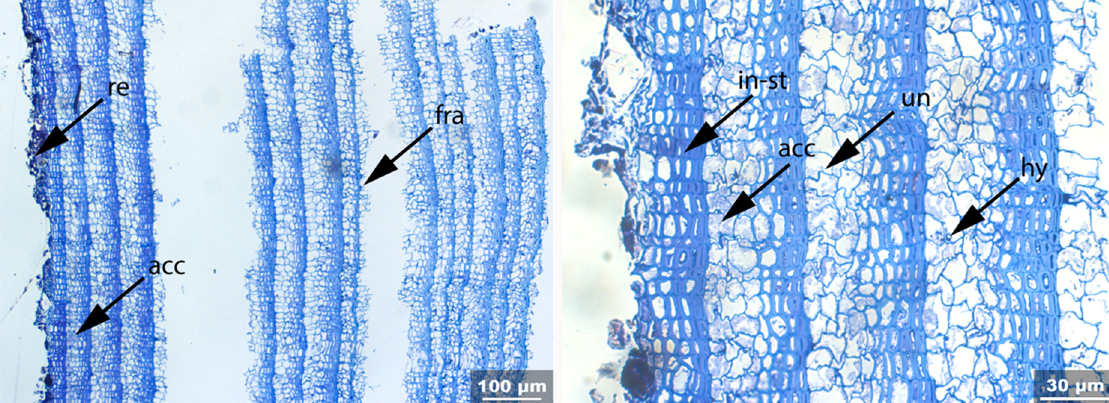
Figure 27. Sample 13. LM shows many fractures of radial thin-walled cells (fra) leading to delamination. Thin-walled cells are unfolded (un); thick-walled secondary cell walls reveal increased staining, especially close to the surface. Thick dark-coloured residue (re) covers the surface. An accumulation of a cloudy substance in the lumen of thin-walled cells (acc) is present; some lumens are completely filled.